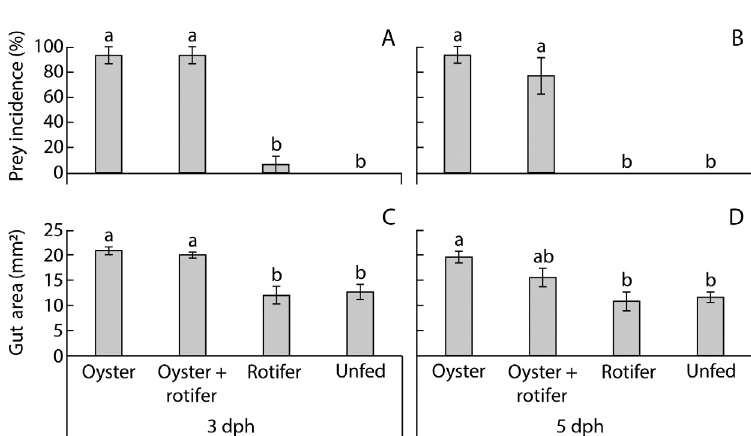
Fig. 3. Effects of diet on (A,B) prey incidence and (C,D) gut area of larval Para- canthurus hepatus at (A,C) 3 and (B,D) 5 d post-hatch (dph). Prey incidence: the percentage of larvae with material in the digestive tract. Data are means ± SE, n = 3. Bars with the same letters are not significantly different according